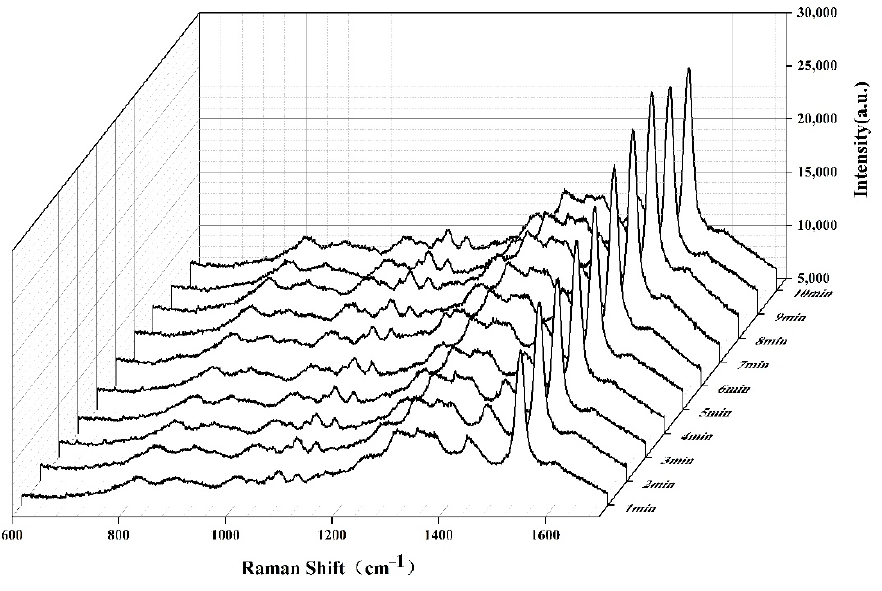
Figure 7. SERS spectrum of dynamic determination of Aspergillus flavus.